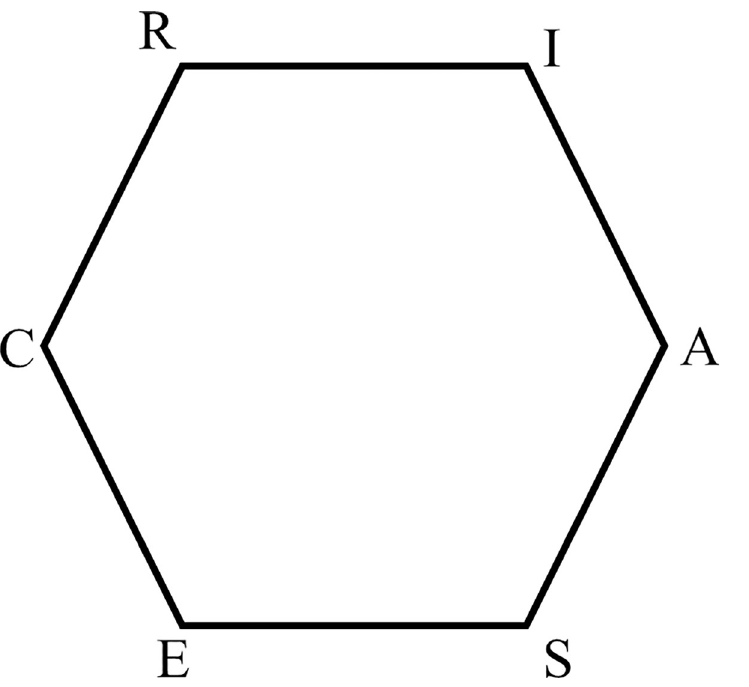
Fig 1. RIASEC model of vocational interest types and environments (from